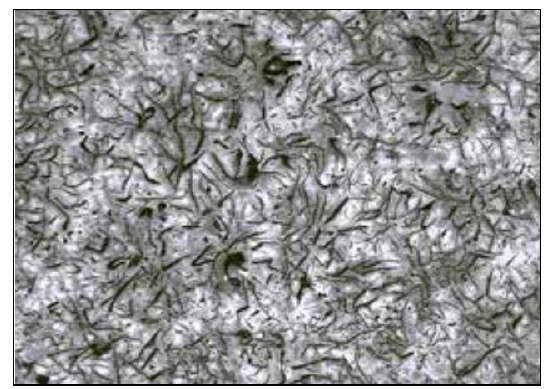
Fig. 1. Typical microstructure of gray cast iron disc